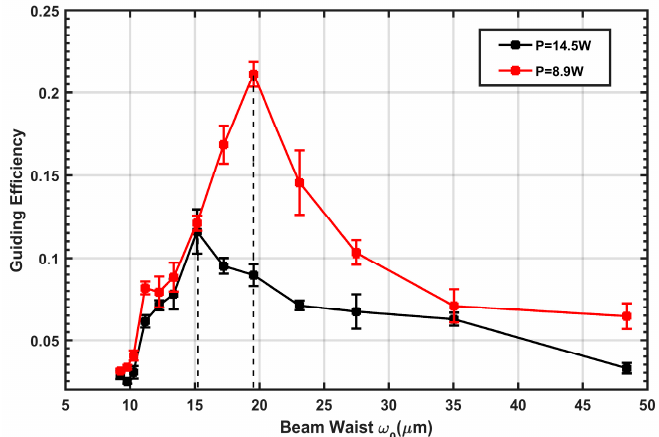
Figure 5. Dependence of guiding efficiency on beam waist at different laser powers, counted after MOT2 was released at 20 ms. Each experimental data point is an average over 10 measurements. The error bars correspond to standard deviation based on counting statistics.